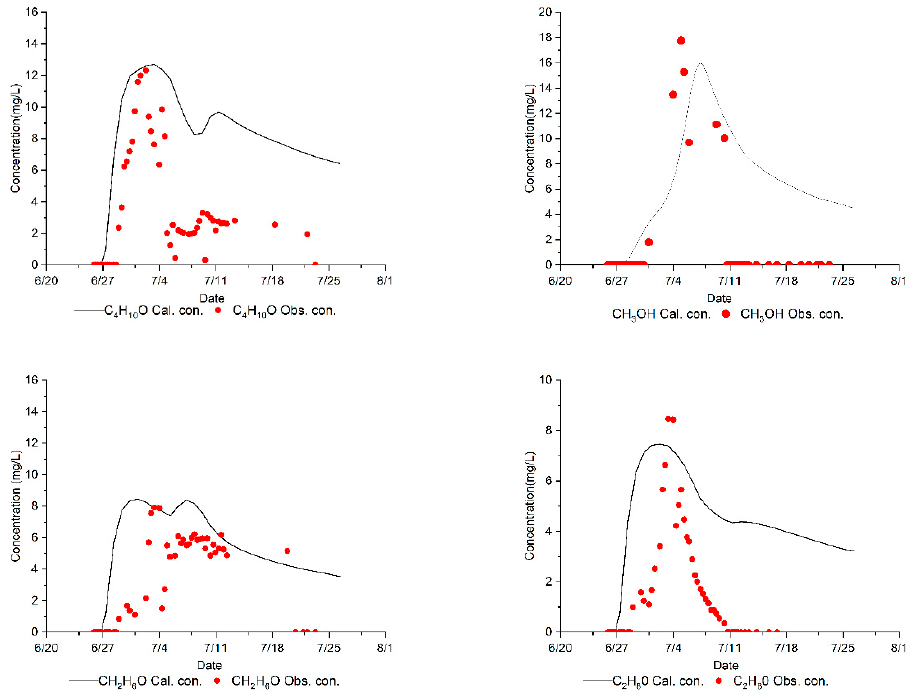
Figure 8. Time dependence curves of observed and calculated concentrations of four alcohol tracers in leaching solution of central monitoring well. Table 1. Correlation coefficient and error between the calculated value of tracer concentration and the observed value in each observation well.